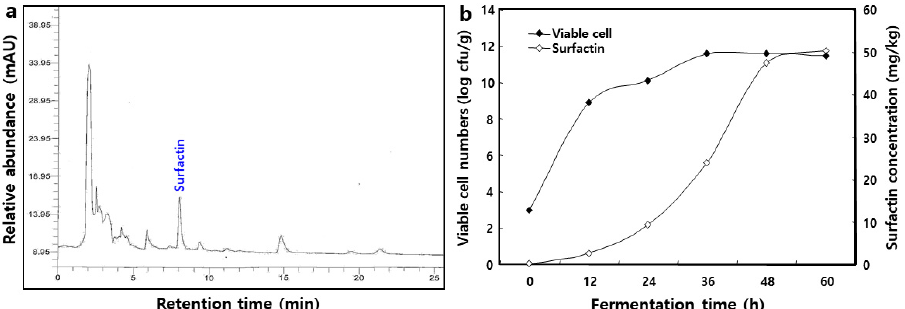
Figure 5. Typical HPLC chromatogram of the 95% methanol extracts in cheonggukjang (fermentation time: 60 h) and changes in the viable cell numbers and surfactin concentration during fermentation of chenonggujang by Bacillus pumilus HY1. ( a ) HPLC chromatogram; and ( b ) viable cell numbers and surfactin concentration.